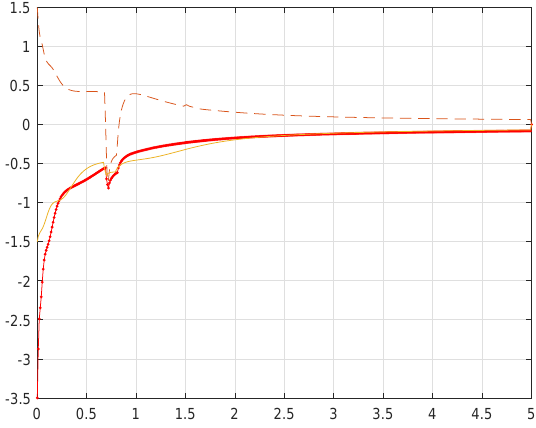
Figure 4. The leader–follower multi-agent system error states ω j ( τ ) .